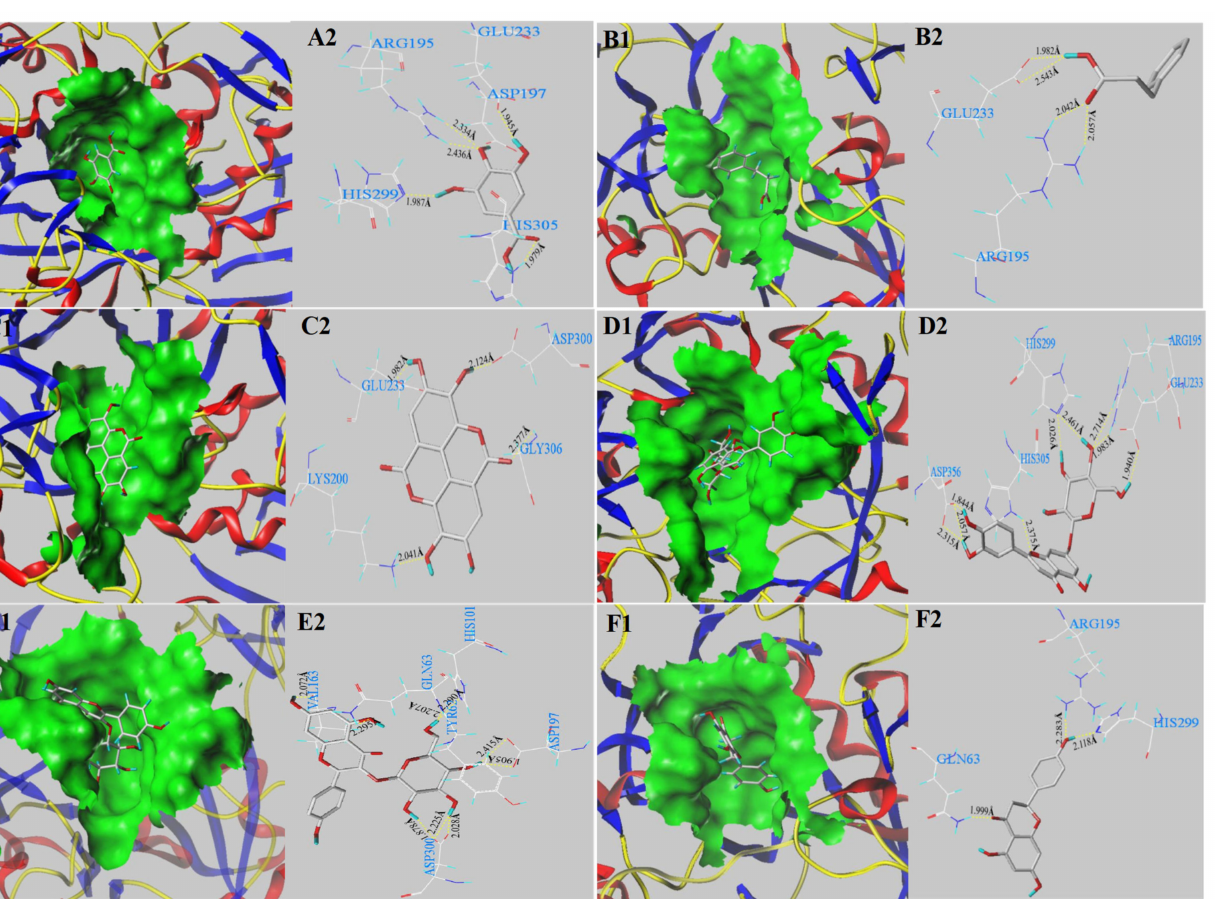
Figure 4. The 3D conformations of the major phenolics docked with α -amylase: gallic acid ( A1 , A2 ); p -hydroxycinnamic acid ( B1 , B2 ); ellagic acid ( C1 , C2 ); luteolin-7- O -glucoside ( D1 , D2 ); astragalin ( E1 , E2 ); naringenin ( F1 , F2 ) with the active pocket of α -amylase. The dashed yellow line presents hydrogen bonds